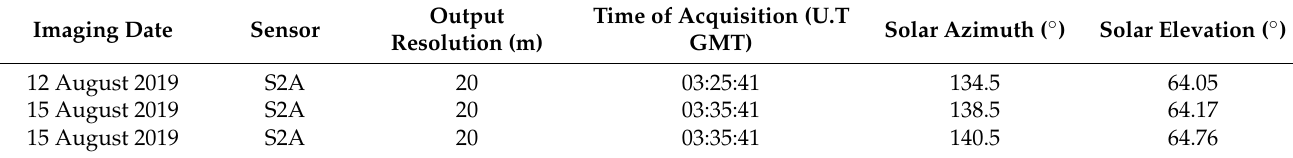
Table 1. Main characteristics of the studied scenes acquired over the study area, the western Guanzhong Plain, China. Imaging Date